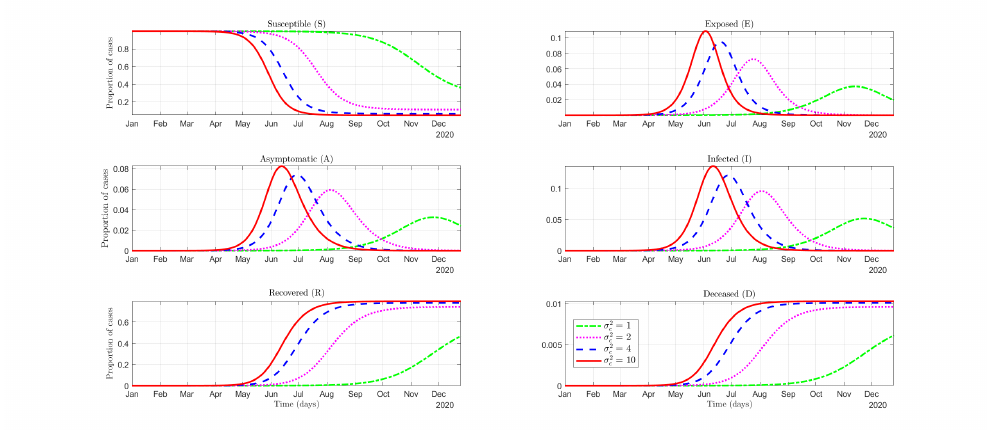
Figure A5. Disease dynamics with an increase in cost heterogeneity.